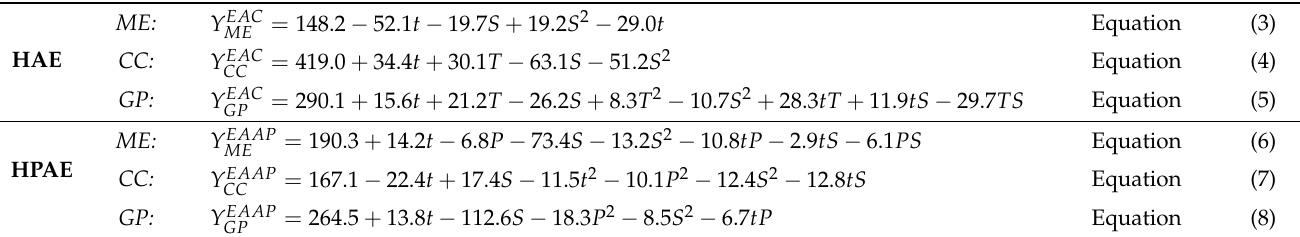
Table 5. Mathematical models of the extraction processes derived from the polynomial model of Equation (2).